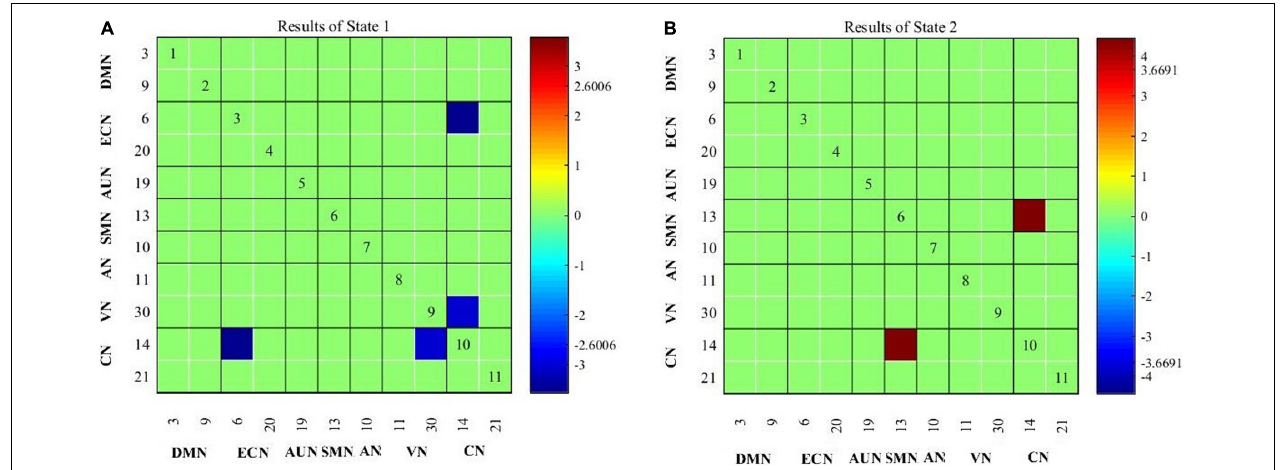
FIGURE 3 | Connectivity results for State 1 (A) and State 2 (B) evaluated using two-sample t -tests, and the significance was corrected using false discovery rate (FDR).